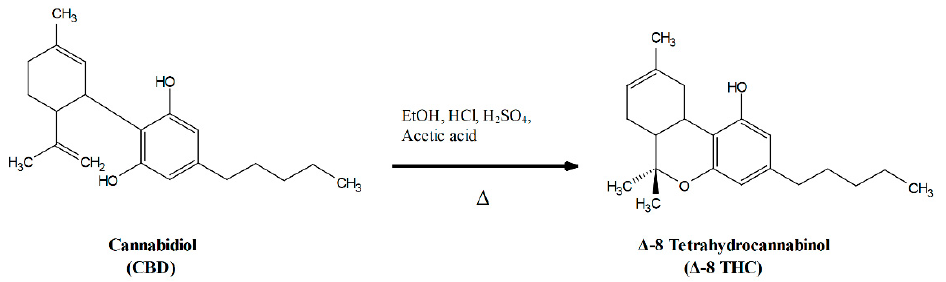
Figure 1. Example reaction scheme for one published synthesis of ∆ -8 THC from CBD [3]. Inter-ring bond length on cannabidiol exaggerated for clarity.